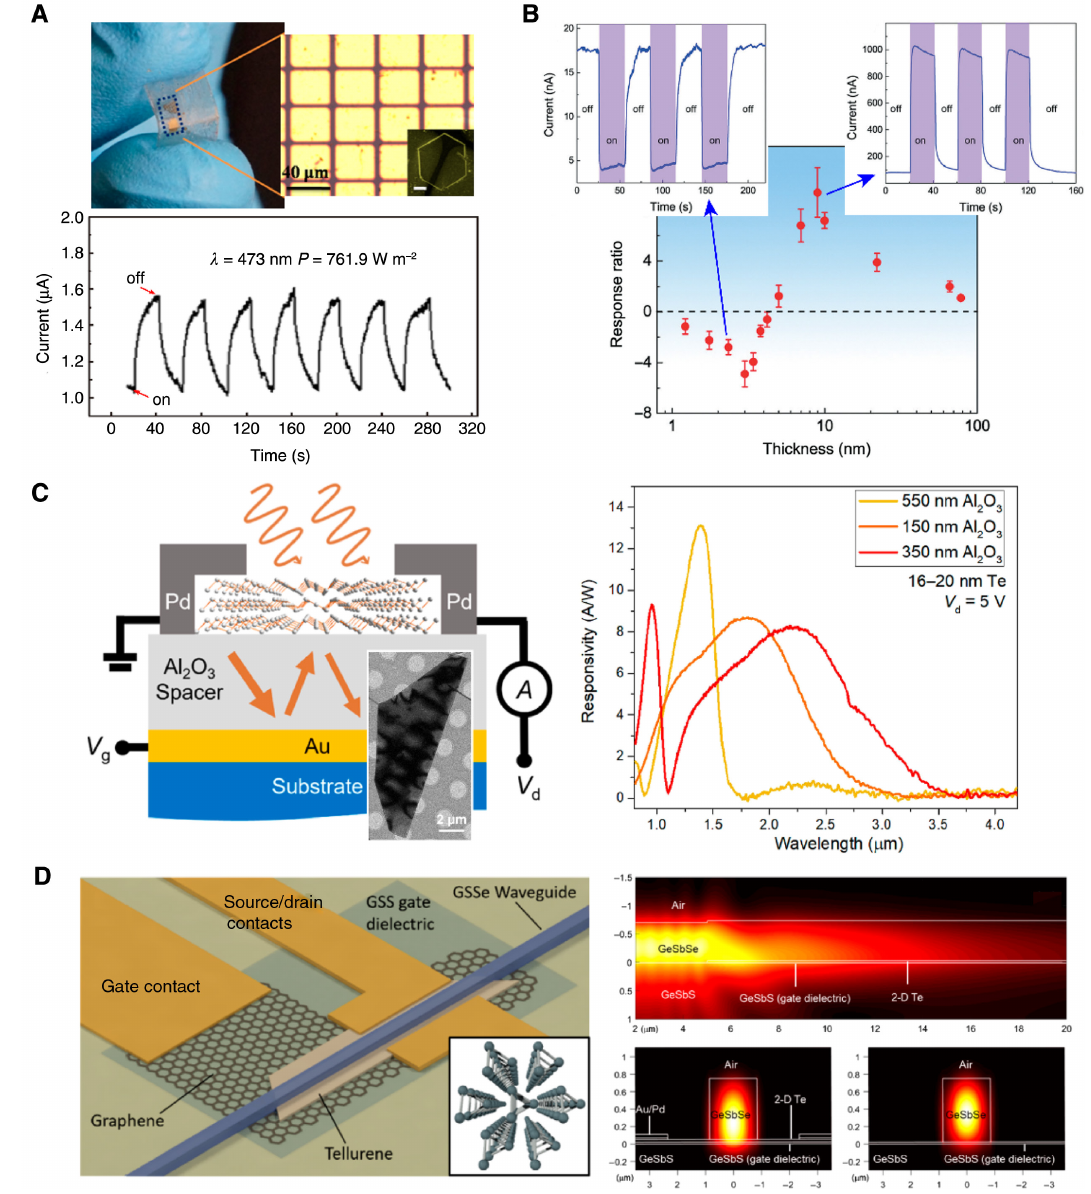
Figure 12: The performance of tellurene-based